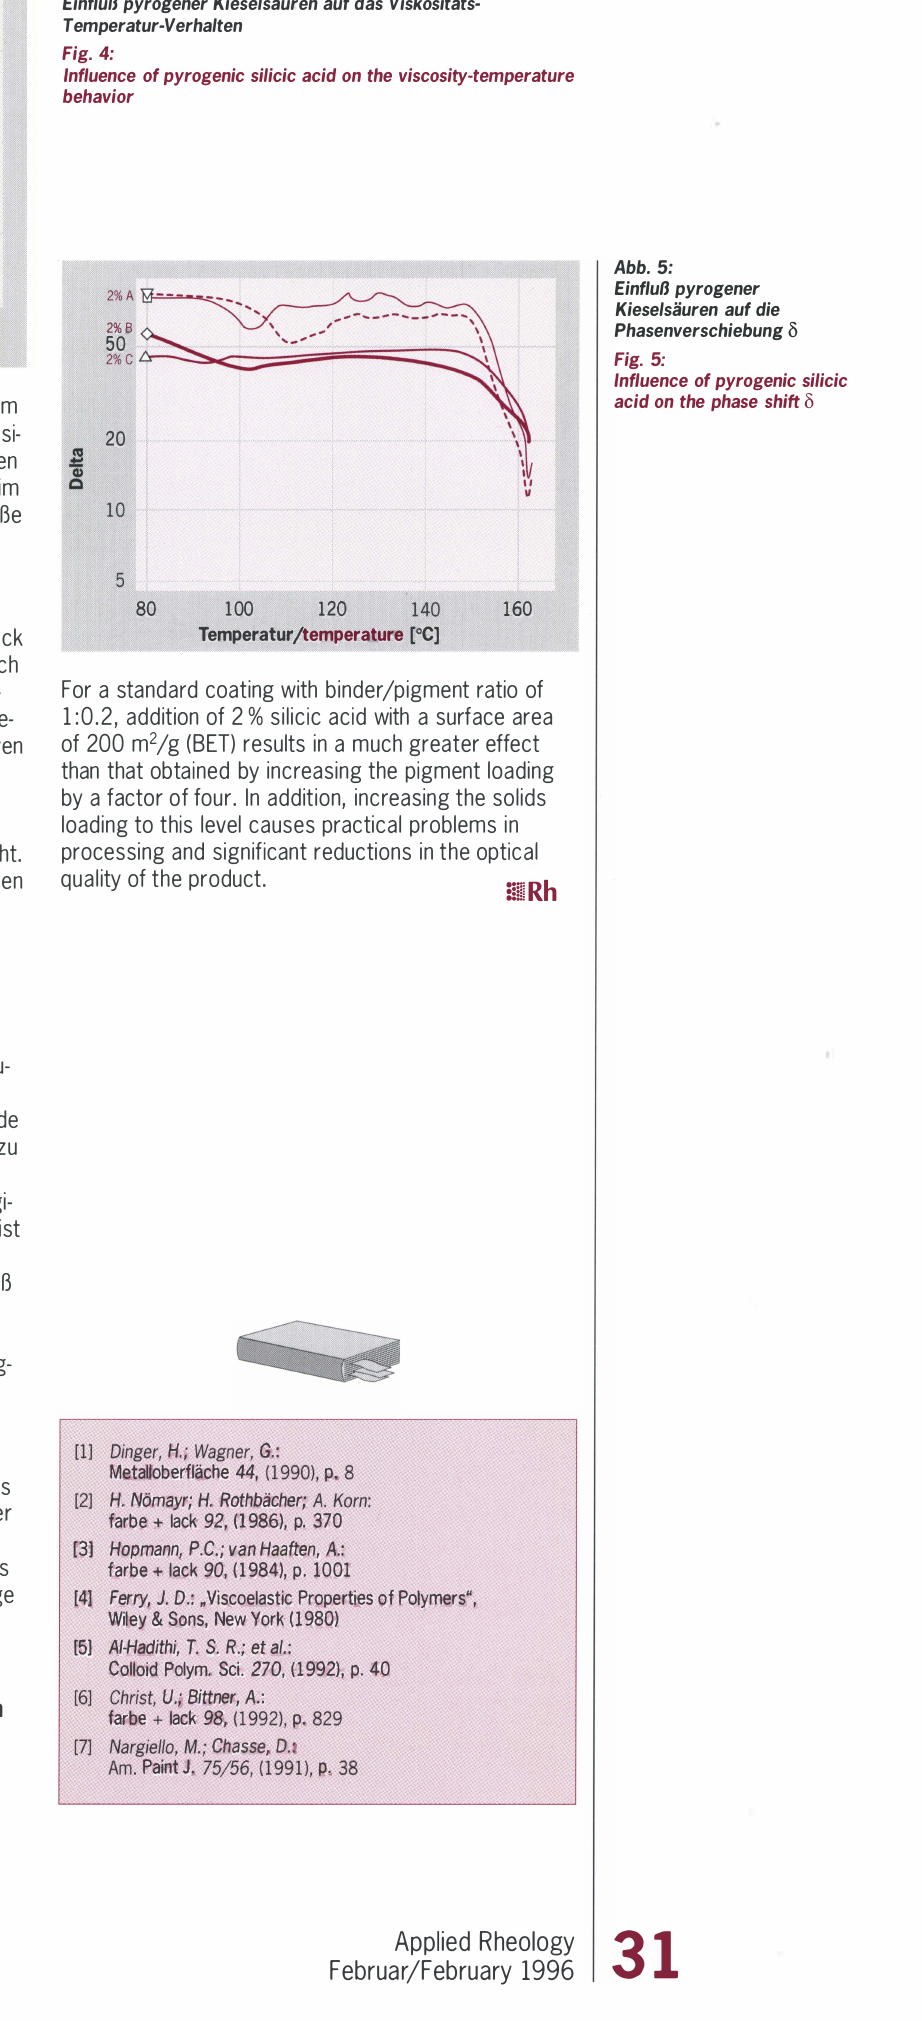
Fig. 4: Influence of pyrogenic silicic acid on the viscosity-temperature behavior